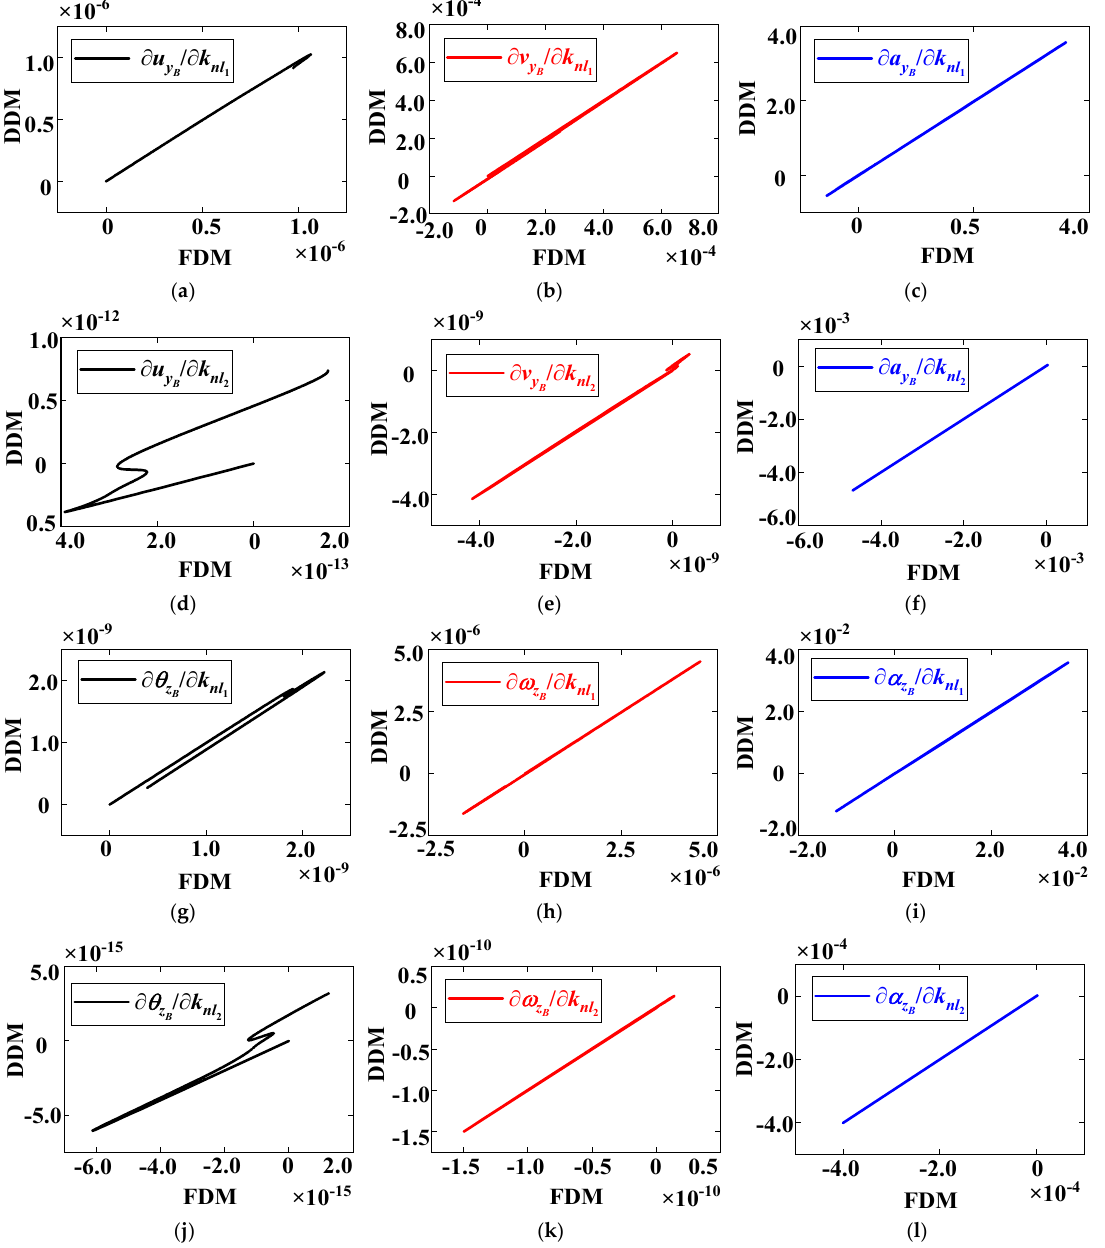
Figure 9. Comparison curve of response sensitivities of point B (translation and rotation displacement, velocity, and acceleration) with respect to nonlinear stiffness parameters k nl 1 ( a – c , g – i ) and k nl 2 ( d – f , j – l ) with FDM and DDM at N t = 5000. Figure 9 illustrates the comparison curve of the response sensitivities (displacement,